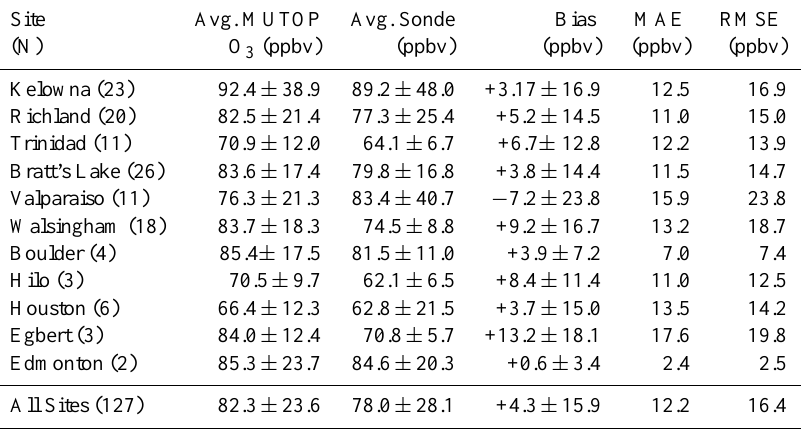
Table 2. Statistical results of MUTOP ozonesonde validation by sonde launch site and for all sites combined ( N = 127), bias is calculated as MUTOP (TES) minus ozonesonde.